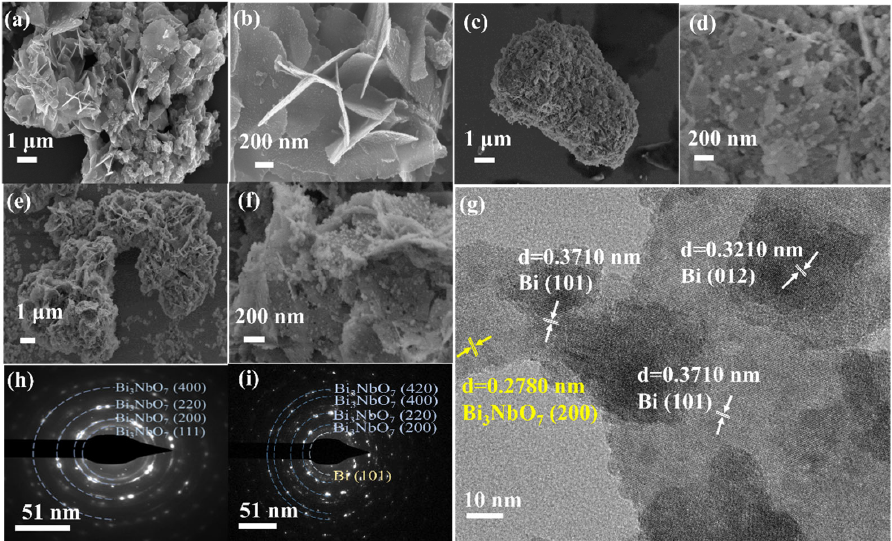
Figure 6. SEM images of ( a , b ) BNO, ( c , d ) 2-BNO and ( e , f ) 2% Bi-2-BNO; TEM images of 2% Bi-2-BNO nanosheets ( g ); SAED images of BNO ( h ) and 2% Bi-2-BNO ( i ).